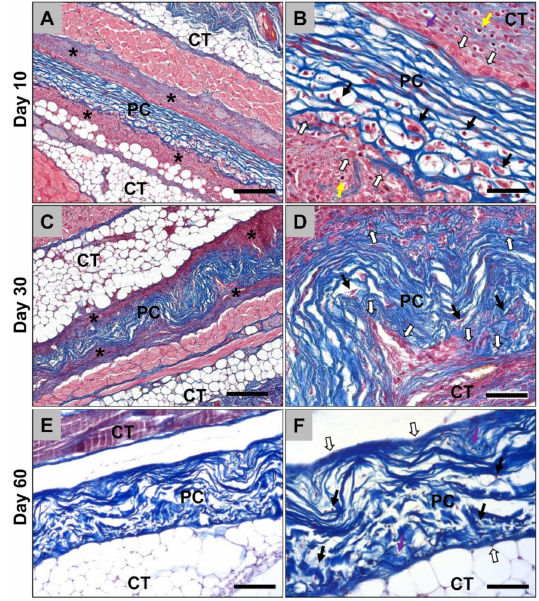
Figure 4. Representative histological images of the porcine pericardium (PC) matrices within the subcutaneous tissue (CT) from day 10 up to day 60 post implantation. ( A ) The membrane (PC) was detectable with the connective tissue (CT) surrounded by a cellular multilayer (asterisks) at day 10 post implantationem (Azan-staining, 10 × magnification, scale bar = 200 µ m). ( B ) A layer of mononuclear cells including mainly macrophages (white arrows) beside single fibroblasts (purple arrows) and lymphocytes (yellow arrows) were observed at the surface of the matrices at this early time point. Only a few mononuclear cells of the monocyte / macrophage line (black arrows) invaded the matrices (Azan-staining, 40 × magnification, scale bar = 50 µ m). ( C ) After 30 days, the matrices (PC) were still observable without signs of bioresorption within the connective tissue (CT) still surrounded by a cell multilayer (asterisks) (Azan-staining, 10 × magnification, scale bar = 200 µ m). ( D ) A distinctive thin layer of macrophages (white arrows) remained at the matrix (PC) surfaces and a slight macrophage ingrowth (black arrows) was observable (Azan-staining, 40 × magnification, scale bar = 50 µ m). ( E ) At day 60 post implantation, the matrices (PC) were embedded within the connective tissue (CT) without any histological signs of further significant occurrence of phagocytic cells indicating their “natural” character (Azan-staining, 10 × magnification, scale bar = 200 µ m). ( F ) Only single cells were most often found at the matrix surfaces, which were mainly identifiable as fibroblasts (white arrows). Within the matrices, low numbers of cells, i.e., single macrophages (black arrows) and fibroblasts (purple arrow) were observed at this late study time point (Azan-staining, 40 × magnification, scale bar = 50 µ m). Histological analysis of the vascularization of the porcine pericardium matrices showed that high numbers of small and medium-sized vessels were detectable within the material-adherent connective tissue at day 10 post implantationem (Figure 5A). At day 30 post implantationem , also high numbers of vessels were found within the surrounding connective tissue and single vessels started to invade the porcine pericardium matrices (Figure 5B). At day 60 post implantationem , lower numbers of vessels were found in the neighborhood of the matrices compared to day 10 and 30, while moderate numbers of small and medium-sized vessels were detectable within the matrices (Figure 5C). Moreover, the ingrowth of these vessels was not correlated with a tissue ingrowth and the vascular walls were adherent to collagen fibers (Figure